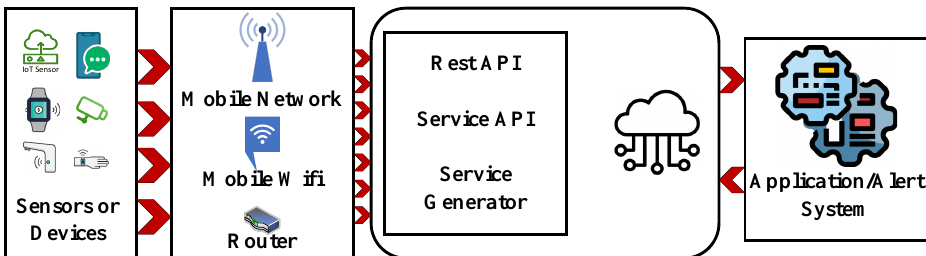
Figure 1. IoT system